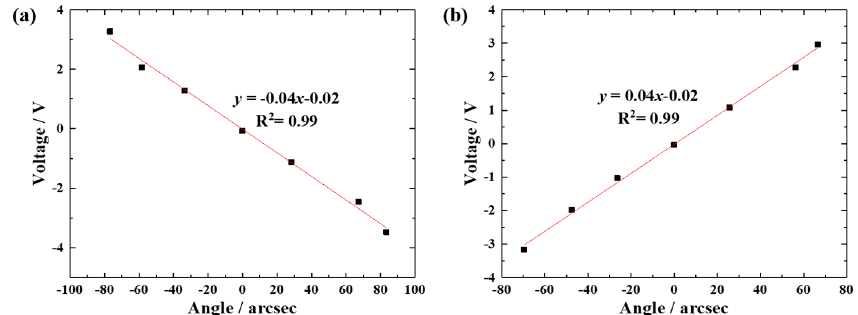
Figure 6. Schematic of the calibration setup.